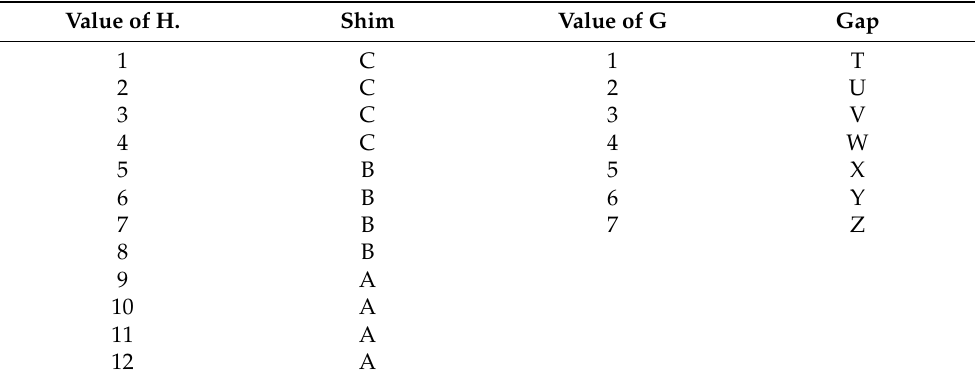
Table 2. H and G values taken from the sensitivity indicator (SI) for shims and gaps shown in Figure 3 [20]. Value of H. Shim Value of G